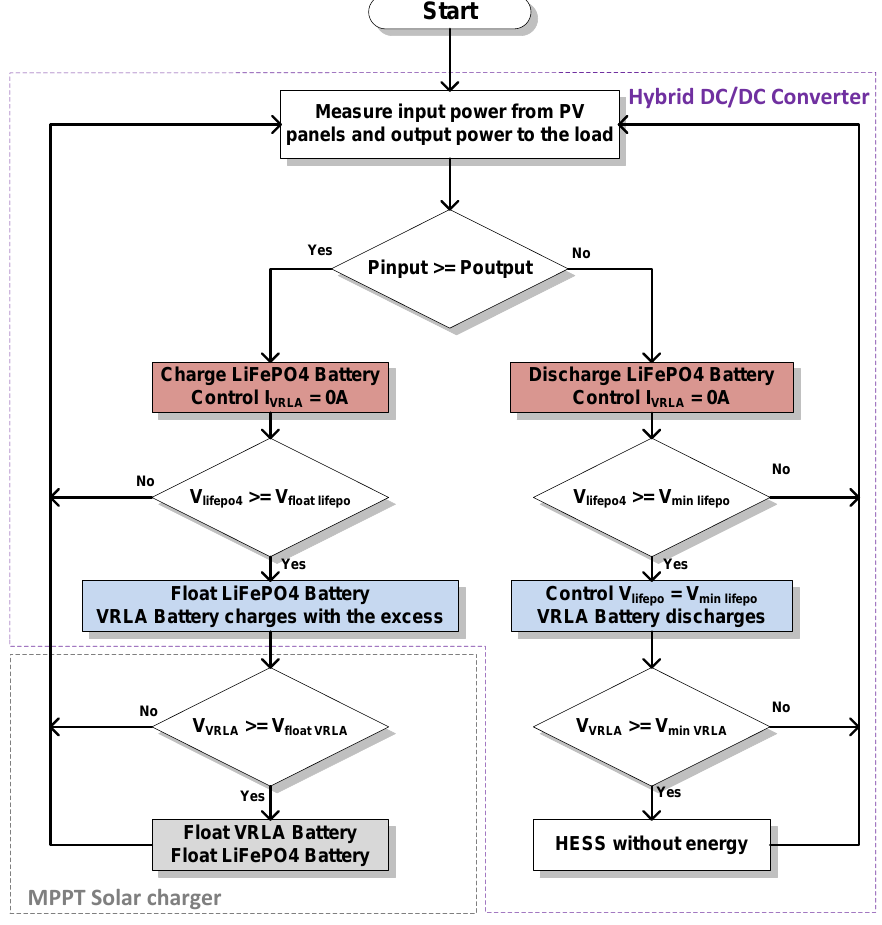
Figure 8. Simple priority EMS. Table 1. ECM parameters for each chemistry.